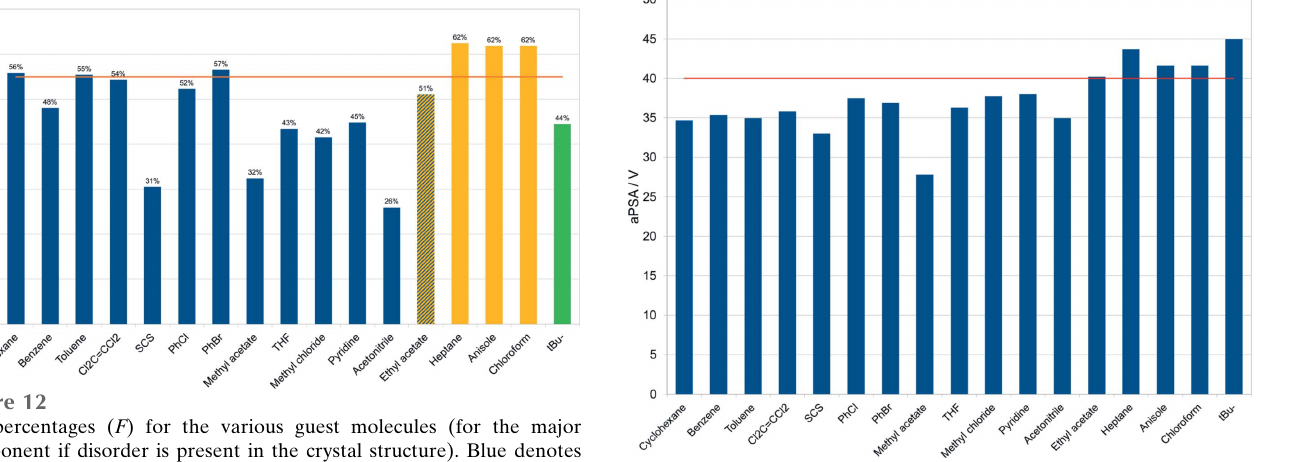
Figure 13 aPSA/ V values for the various guest molecules. The final column indicates the corresponding value for the t Bu group. The red line corresponds to aPSA/ V =